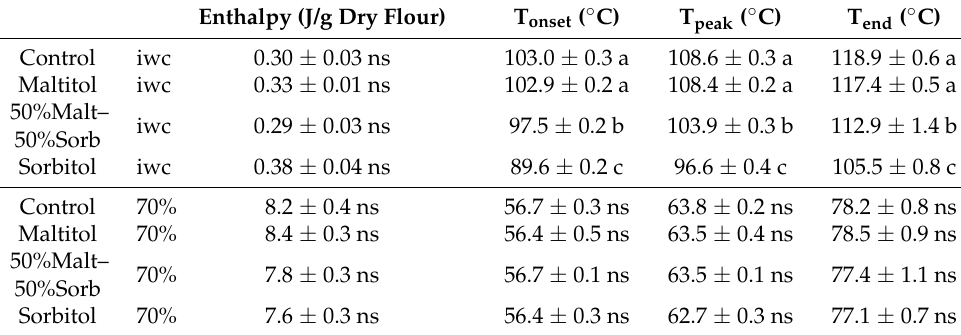
Figure 6. Examples of thermograms obtained by calorimetry with the substituted and reference doughs ( a ) and mean enthalpy of starch gelatinization as a function of temperature in control and no-added-sugar biscuit doughs ( b ) ( n = 3). Doughs in water excess (70%). Table 5. Starch gelatinization characteristics in doughs at initial water content (iwc) and in water excess (70%). Different letters within the same column for the same water content reflect significant differences (Duncan test, α =